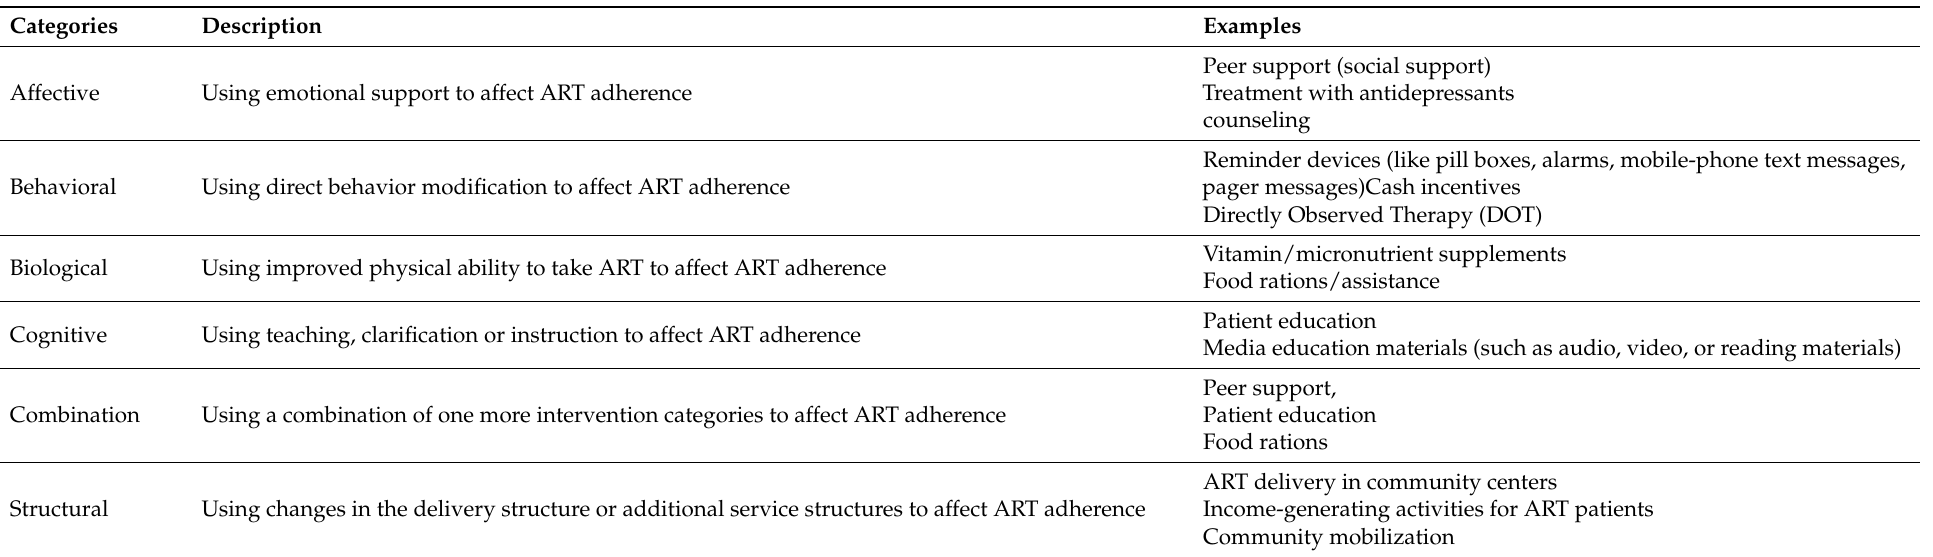
Table 2. Categories of adherence